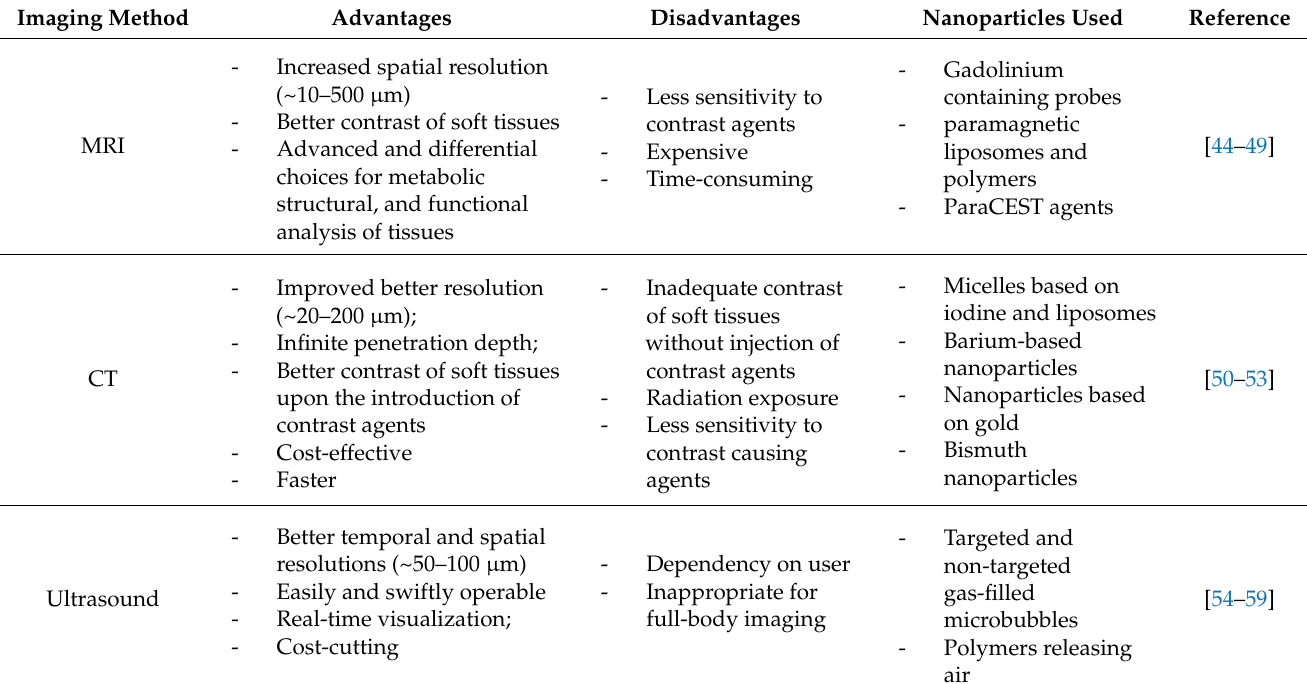
Table 4. Application of nanotechnology for different imaging approaches. Imaging